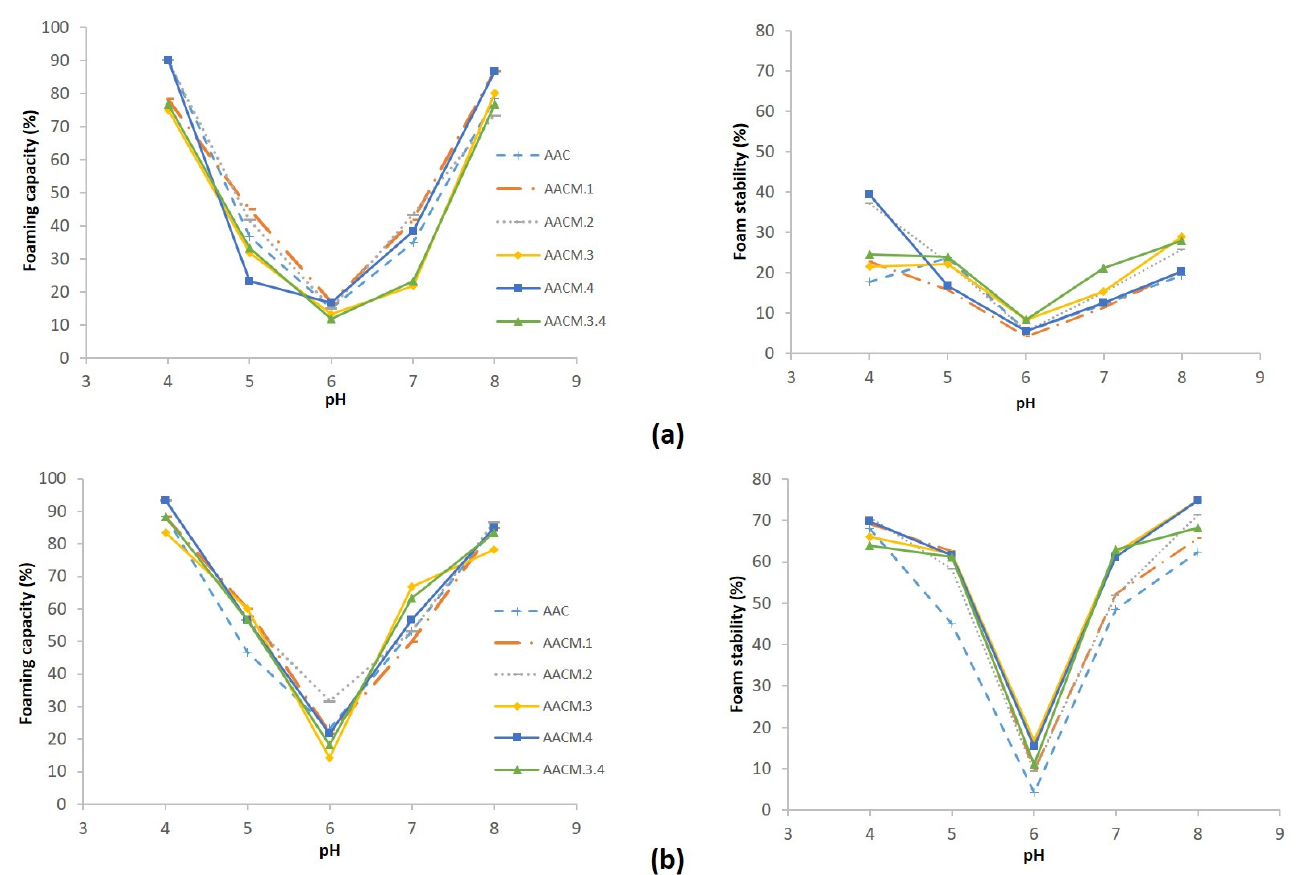
Figure 3. Foaming capacity (FC) and foam stability (FS) of AAC and their modified polypeptides at low NaCl concentration ( a ) and high NaCl concentration ( b ) at different pH conditions. AAC: blue dash line; AACM.1: orange; AACM.2: gray dotted line; AACM.3: yellow; AACM.4, blue; AACM.3.4 green. The results obtained are the mean of triplicate assays.